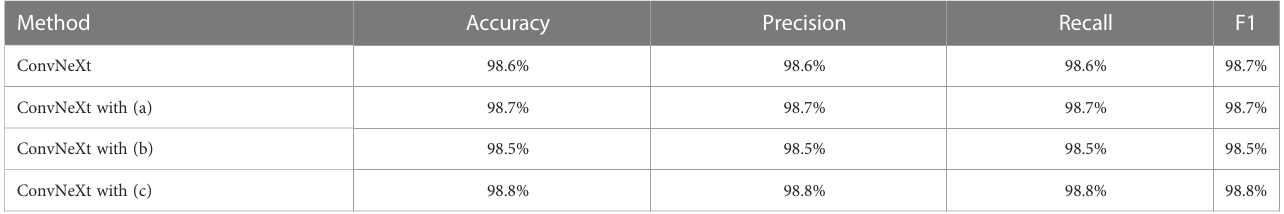
TABLE 3 Performance comparison of different CBAM embedding position